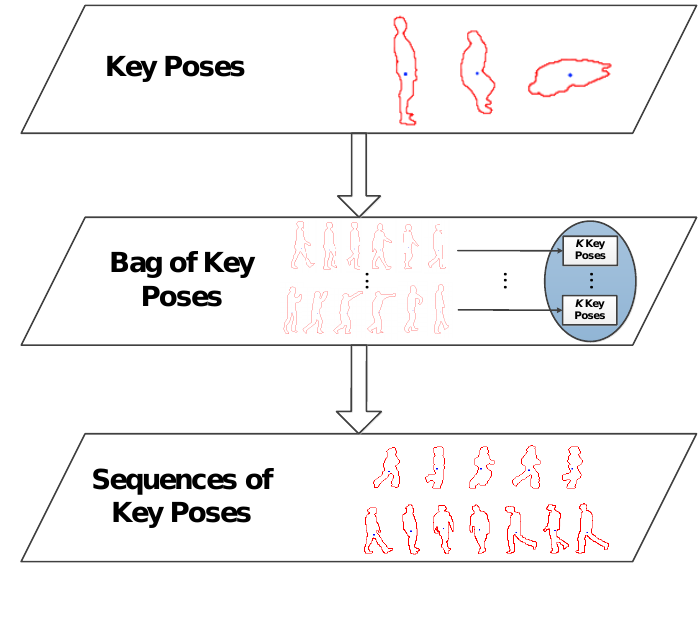
Figure 4. Outline of the learning stage. Using the pose representations, key poses are obtained for each action. In this way, a bag of key poses model is learned. The temporal relation between key poses is modelled using sequences of key